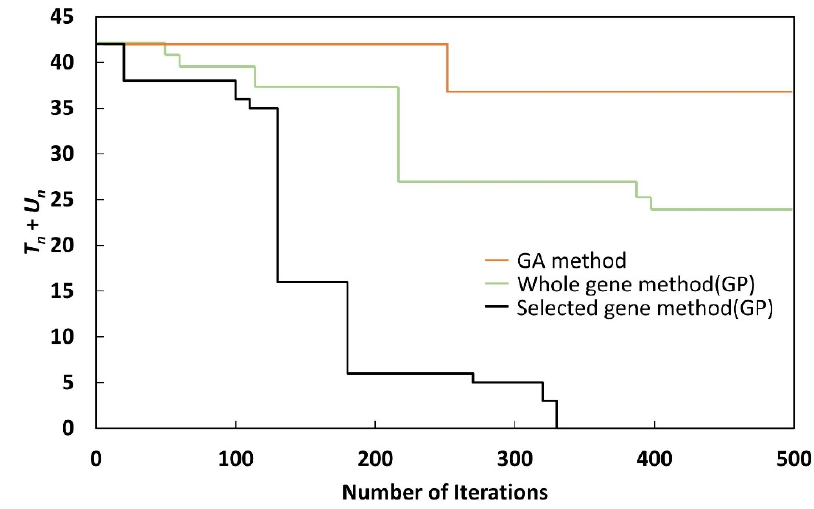
Figure 10. GP results for the minimized fitness function (2019).